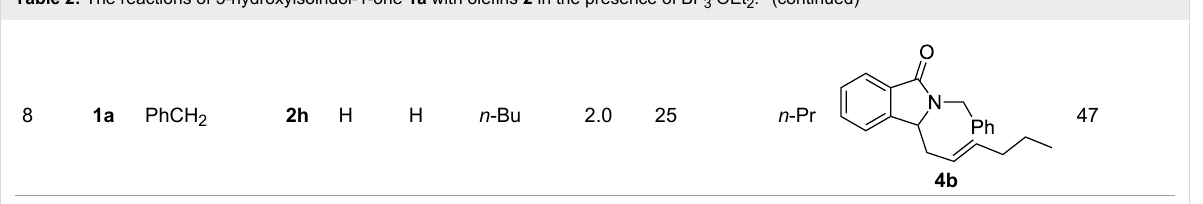
Table 2: The reactions of 3-hydroxyisoindol-1-one 1a with olefins 2 in the presence of BF 3 ·OEt 2 . a (continued)